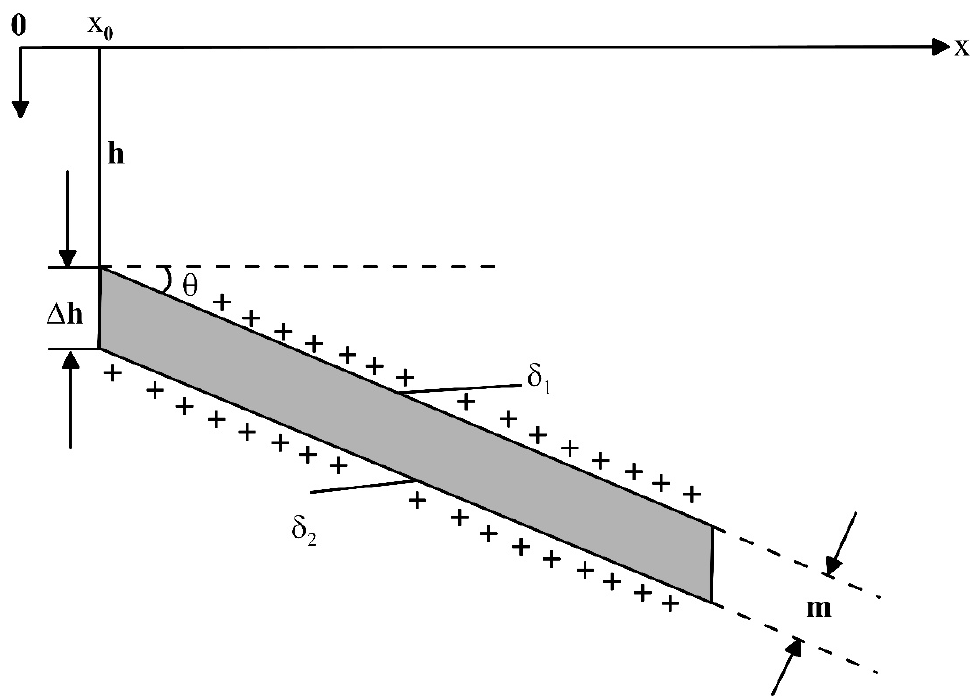
Figure 1. The source geometry for the 2D dipping layer/bed.